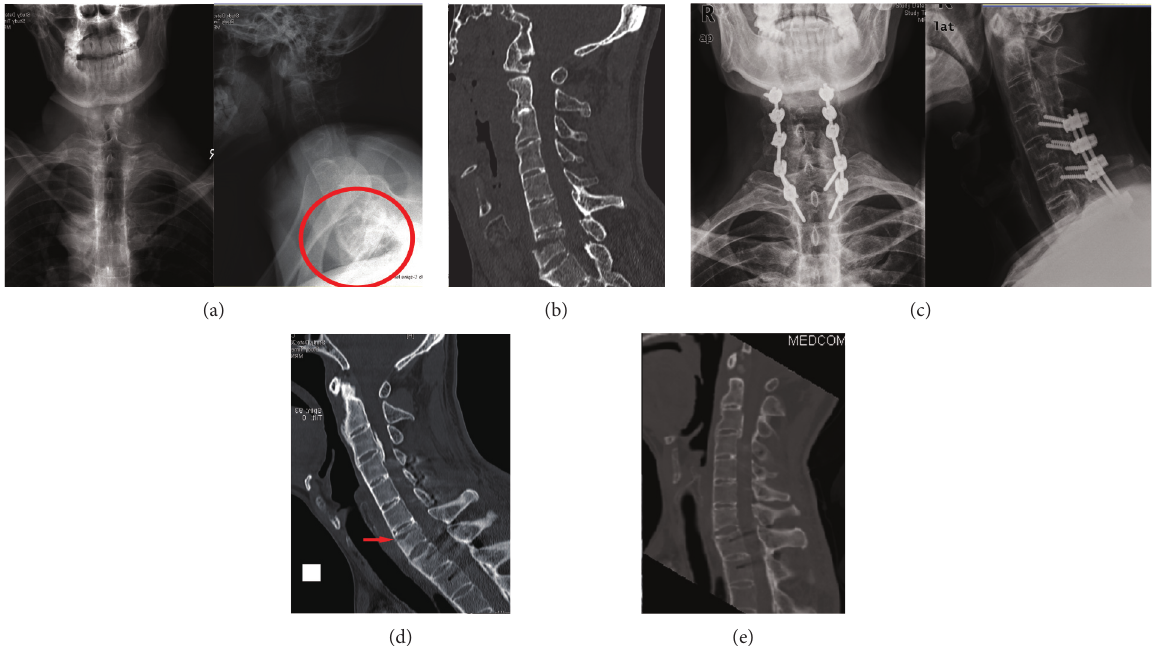
Figure 9: Treatment of type IIA; most fracture patients can be treated with posterior surgery, which is safer.